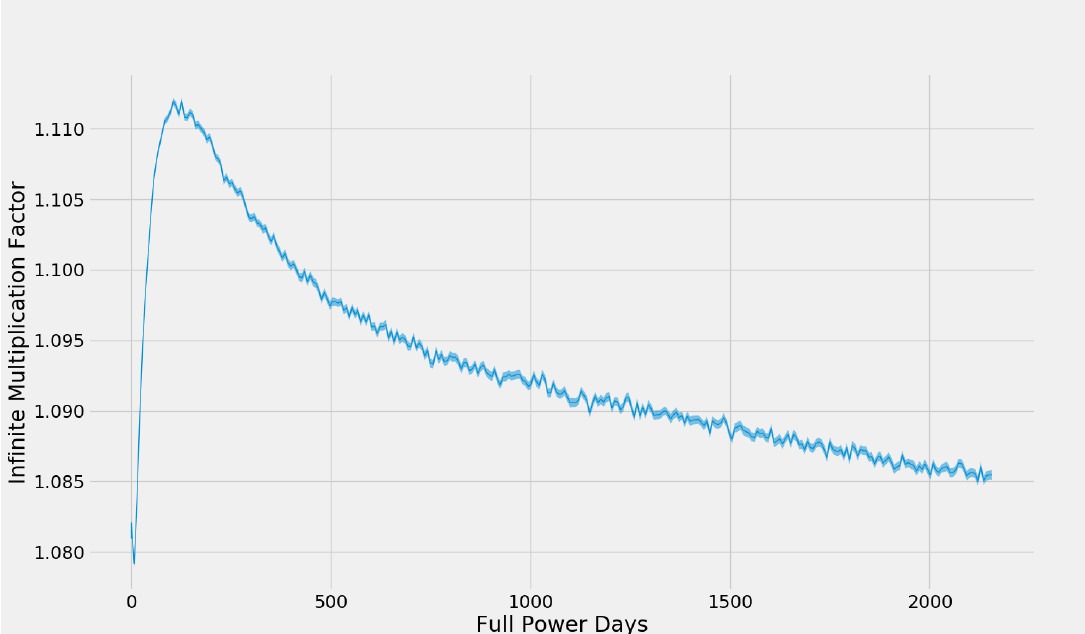
Figure 1. Infinite multiplication factor over burnup given a constant refueling